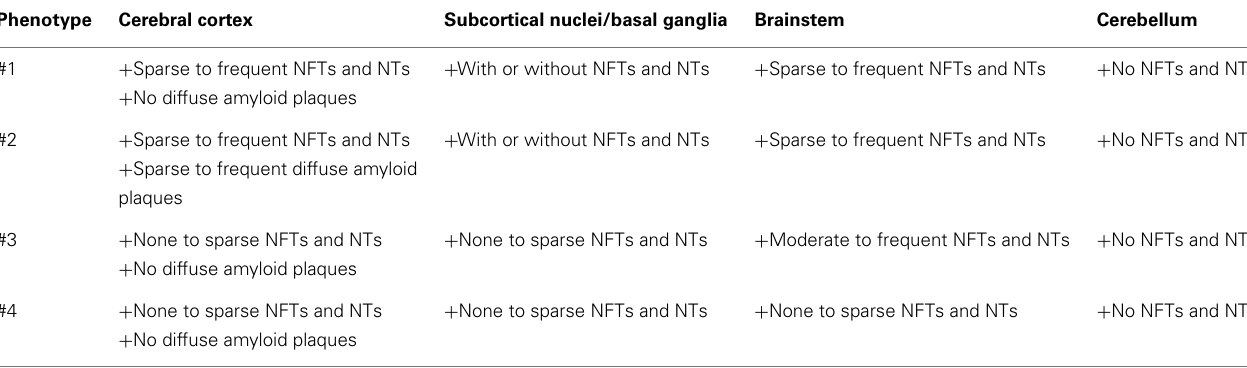
Table 1 |The diversity of pathological findings in CTE has lead to the emergence of four distinct